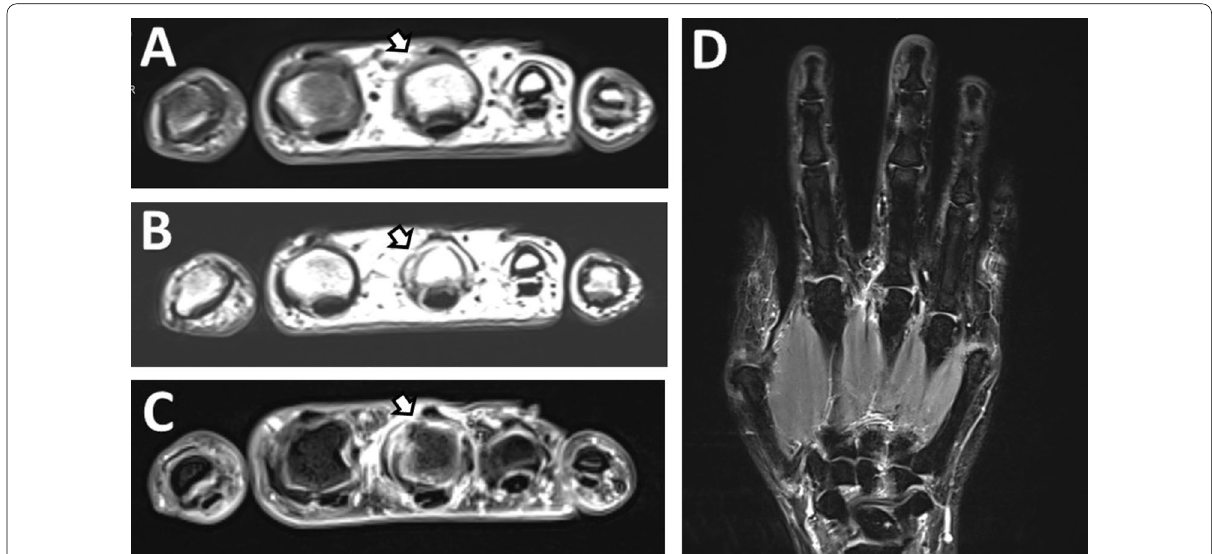
Fig. 5 Female patient 34 years old, complaining of post-traumatic pain over the base of the dorsal aspect middle finger. Axial T1WI ( a ), axial T2WI ( b ), axial proton density fat-saturated ( c ) and coronal STIR ( d ) weighted imaging of the right middle finger showing partial interruption of the fibers of the radial sagittal band of the middle finger (white arrow) at the level of the metacarpophalangeal (MCP) joint with surrounding edematous changes. Diagnosis was radial sagittal band partial tear of the right middle